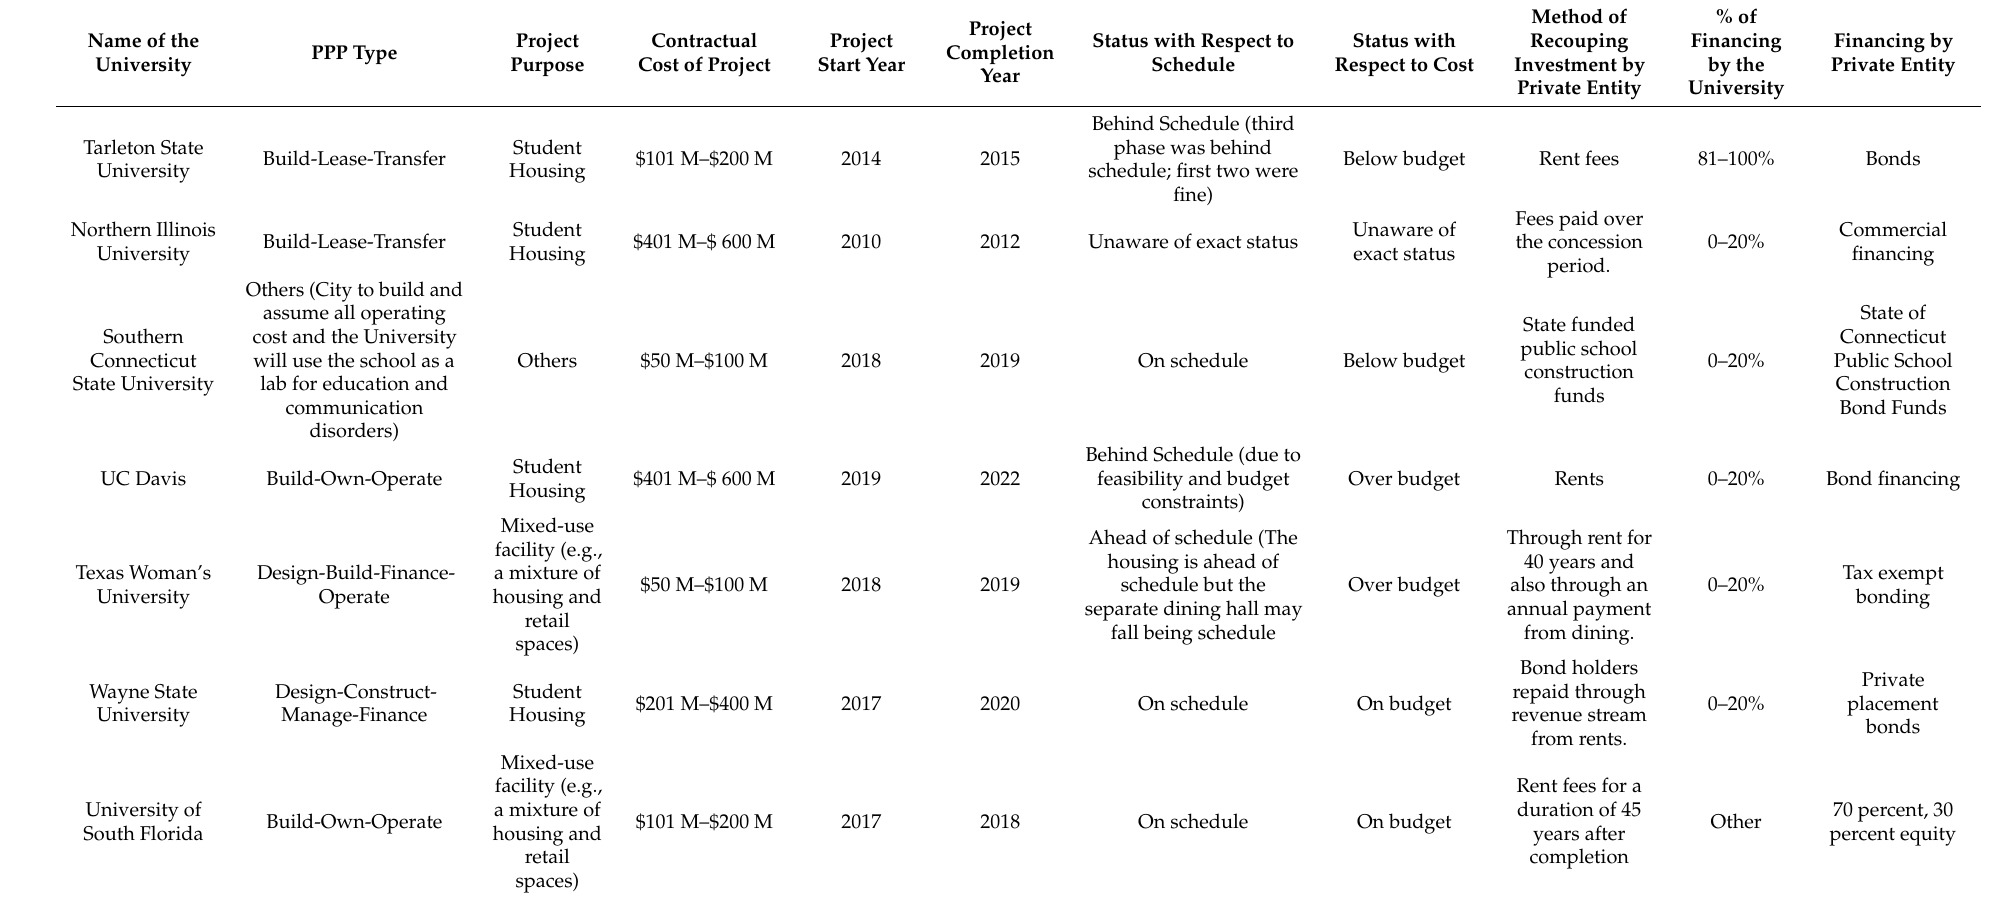
Table 4. Results of the questionnaire